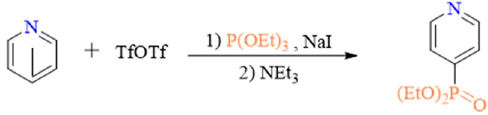
Figure 1. Free energy profile of pyridine activation and nucleophilic addition. Figure 2. Free energy profile of dihydropyridine rearomatization to afford the final product (path A). 2.1.1. Activation of Pyridine and Nucleophilic Addition Based on our calculations, the reaction is initiated by the nucleophilic attack of pyri ‐ dine on Tf 2 O (S N 2 reaction) to form N ‐ (trifluoromethylsulfonyl) pyridium triflate 2 and TfO − via the TS 1/2 transition state [37]. The free energy barrier of this reaction step is only 1.2 kcal/mol in acetonitrile (relative to pyridine + Tf 2 O), which agrees well with the ex ‐ pected barrier value, considering the experimental conditions ( − 78 °C to room tempera ‐ ture). The S–O(OTf) bond in TS 1/2 is elongated to 1.73 Å, whereas the N–S bond